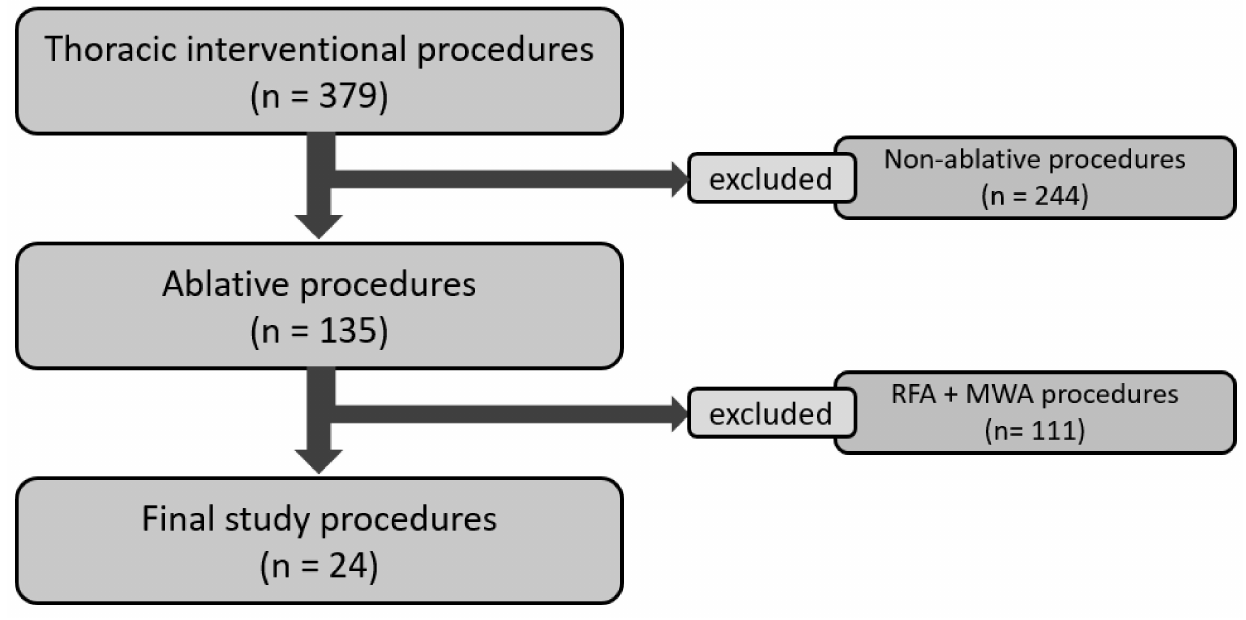
Figure 1. Patient selection